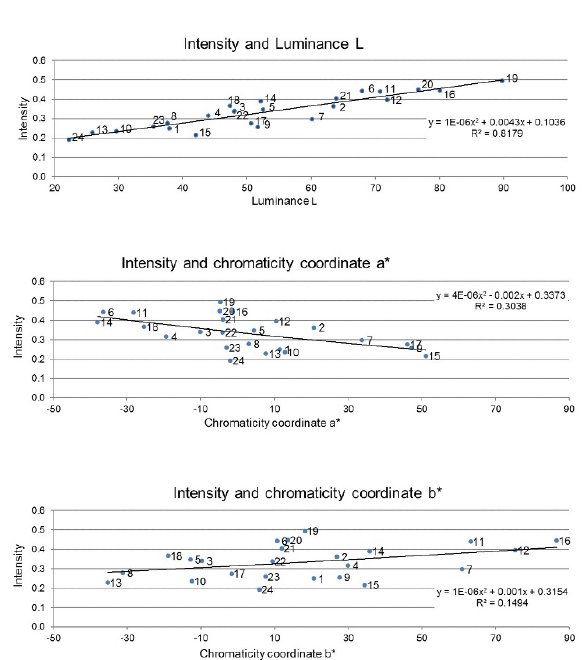
Figure 4. Relationship between intensity and CIE chromatic coordinates